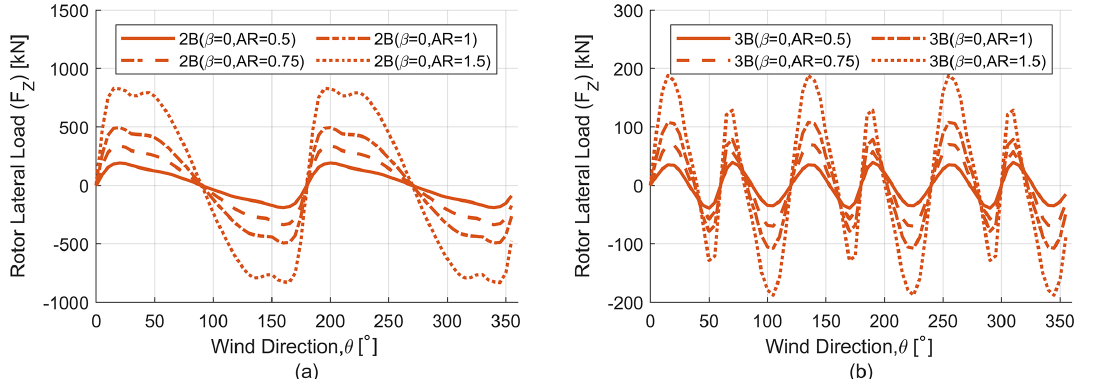
Figure 23. Parked rotor lateral load ( F Z ) analysis for different aspect ratio (AR) rotors. (a) Parked lateral load ( F Z ) for two-bladed (2B) rotors. (b) Parked lateral load ( F Z ) for three-bladed (3B)